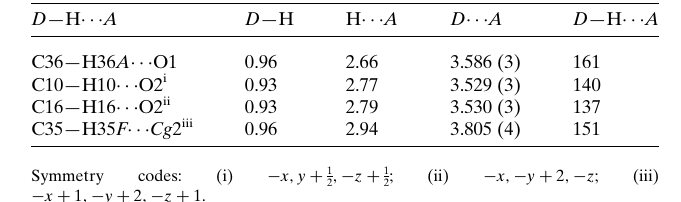
Table 4 Hydrogen-bond geometry (A˚ , (cid:3) ) for (II). Cg 2 is the centroid of the C8–C13 ring.